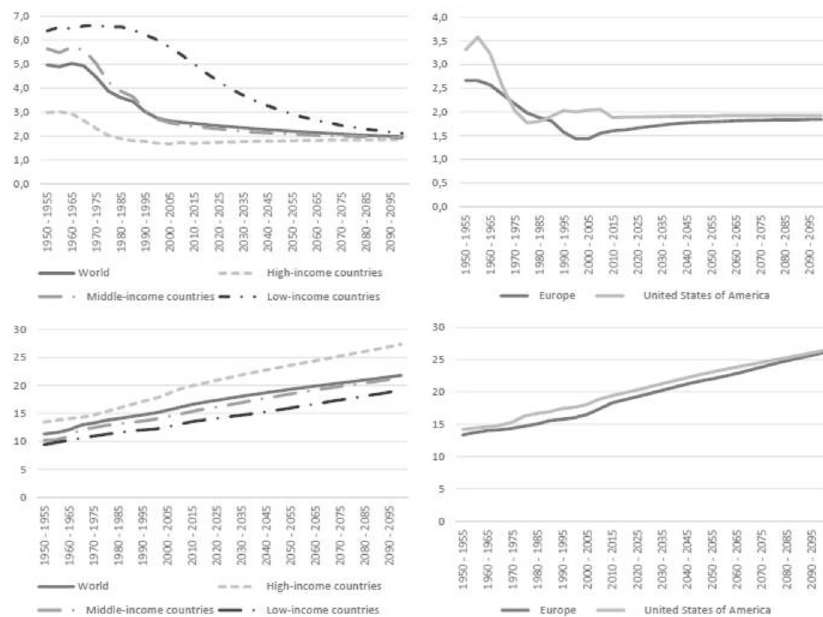
Fig. 2 Fertility and longevity. First row: fertility rate (number of children per woman). Second row: life expectancy at 65 years of age. Source : United Nations, Population Division